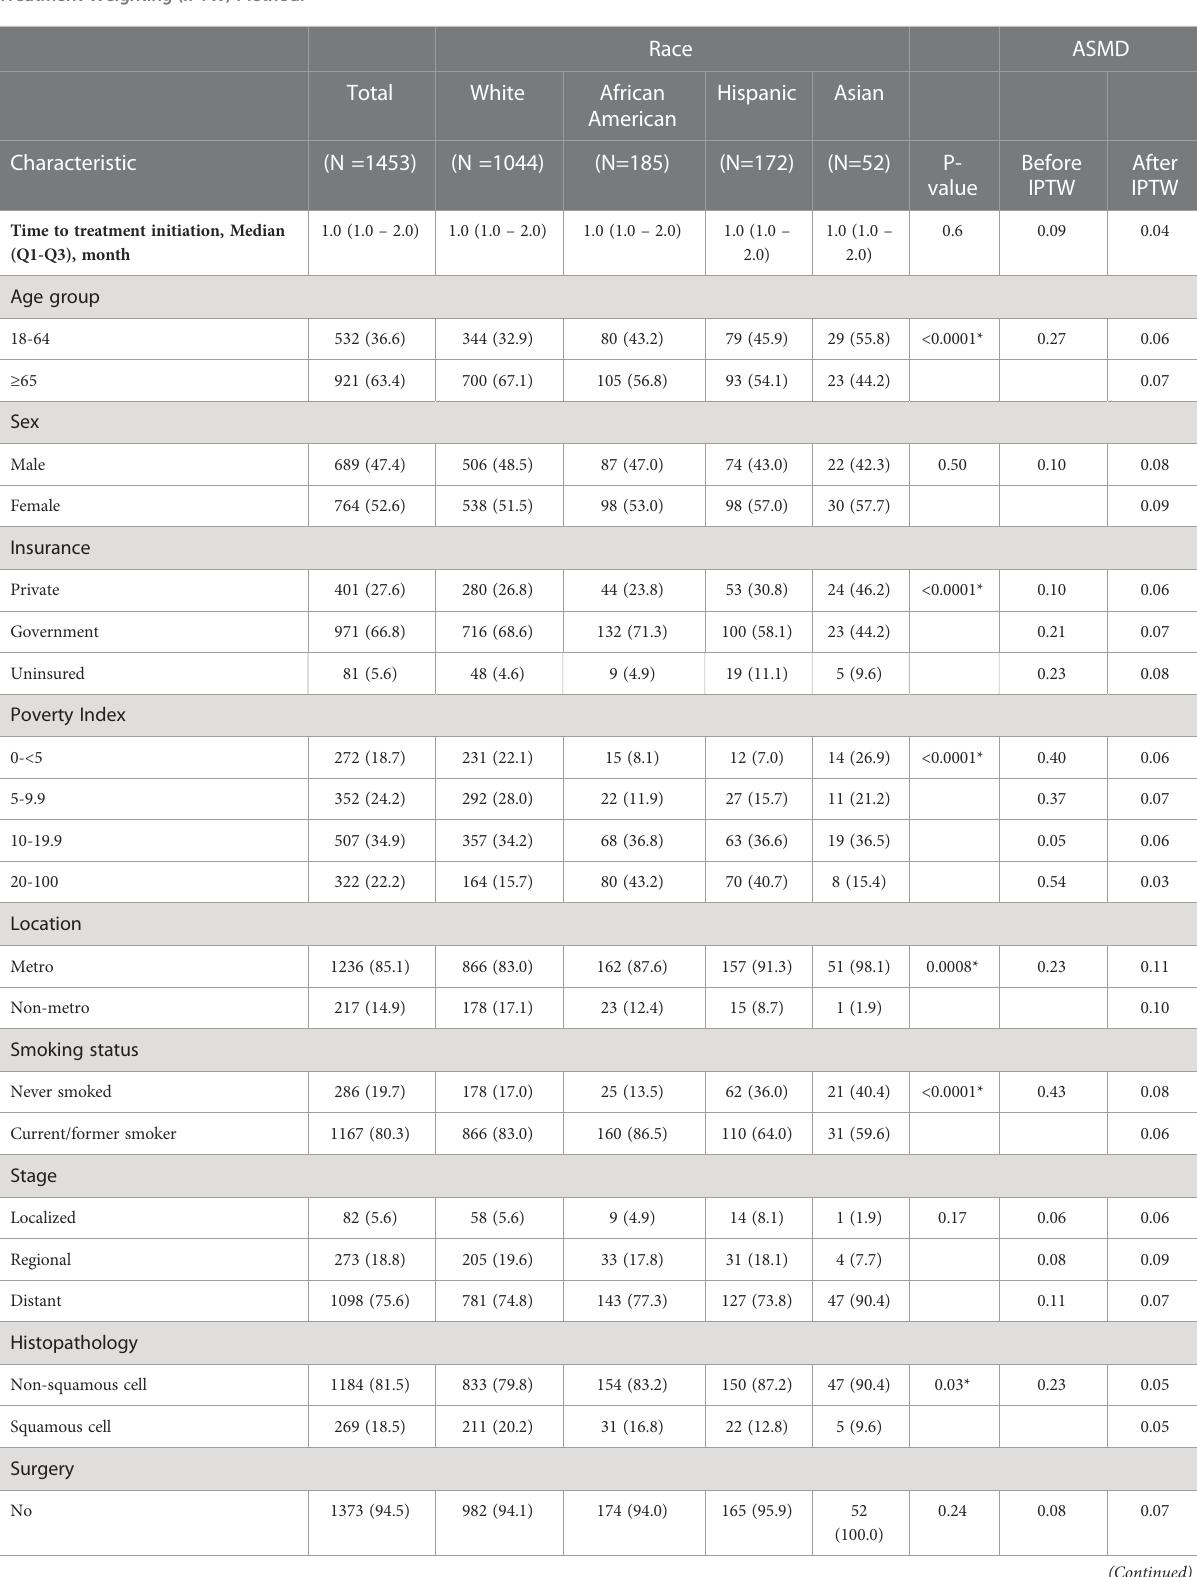
TABLE 1 Descriptive characteristics of 1453 Patients with Non-Small Cell Lung Cancer Identi fi ed in the Texas Cancer Registry from October 2015 to December 2018 and Absolute Standardized Mean Differences (ASMD) Before and After Propensity Score Analysis using the Inverse Probability Treatment Weighting (IPTW)